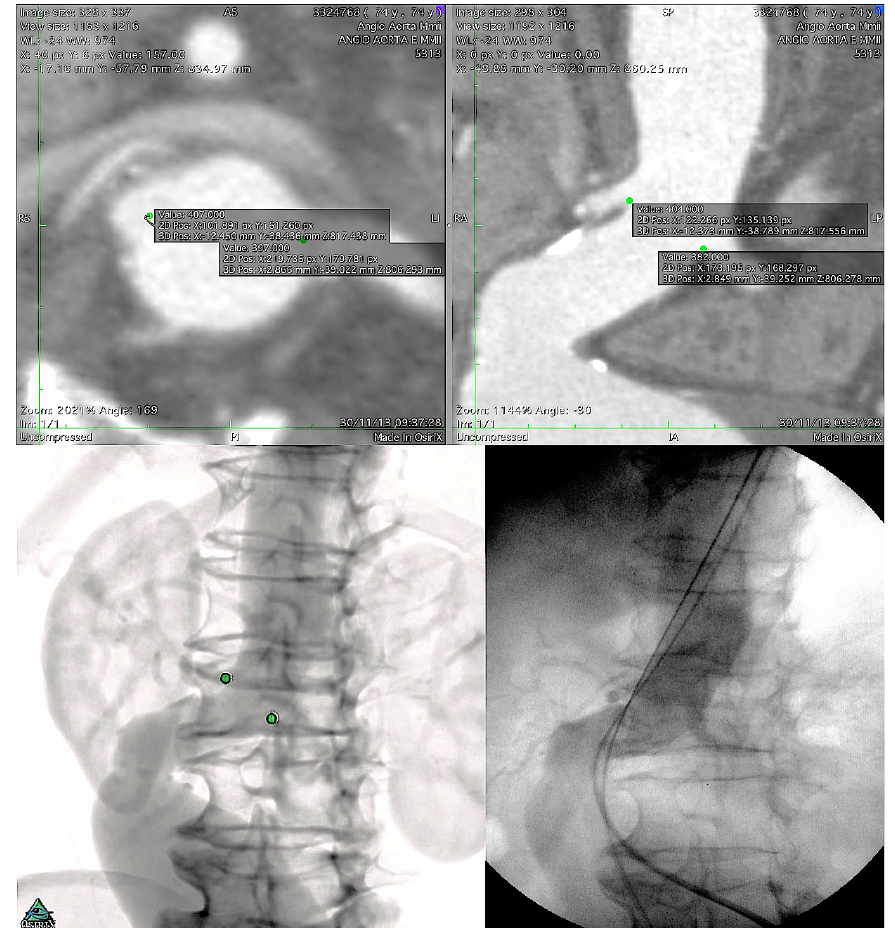
Fig. 1 - Up - ostial renal artery markings in axial projection, with auxiliary view on longitudinal section (at